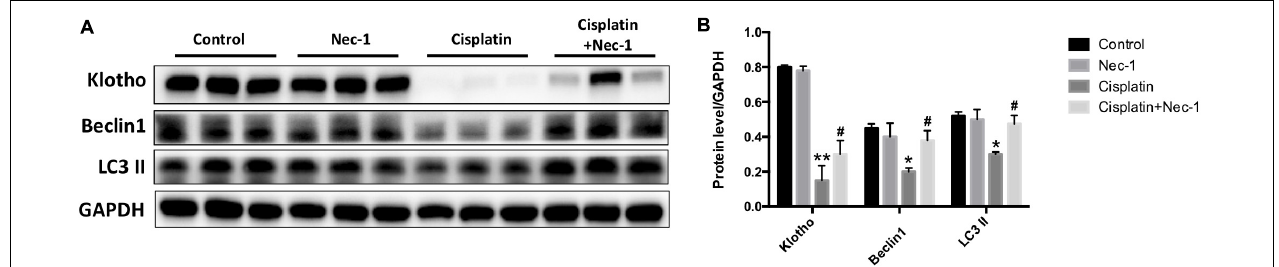
FIGURE 5 | Nec-1 retains renal Klotho and autophagy-related proteins levels. (A,B) The renal Klotho, Beclin-1, and LC3-II protein levels were significantly decreased in the kidneys of mice after cisplatin administration ( ∗∗ p < 0.01, ∗ p < 0.05 versus control group). Nec-1 treatment effectively retained renal Klotho, Beclin-1, and LC3-II levels following cisplatin insult (# p < 0.05 versus cisplatin